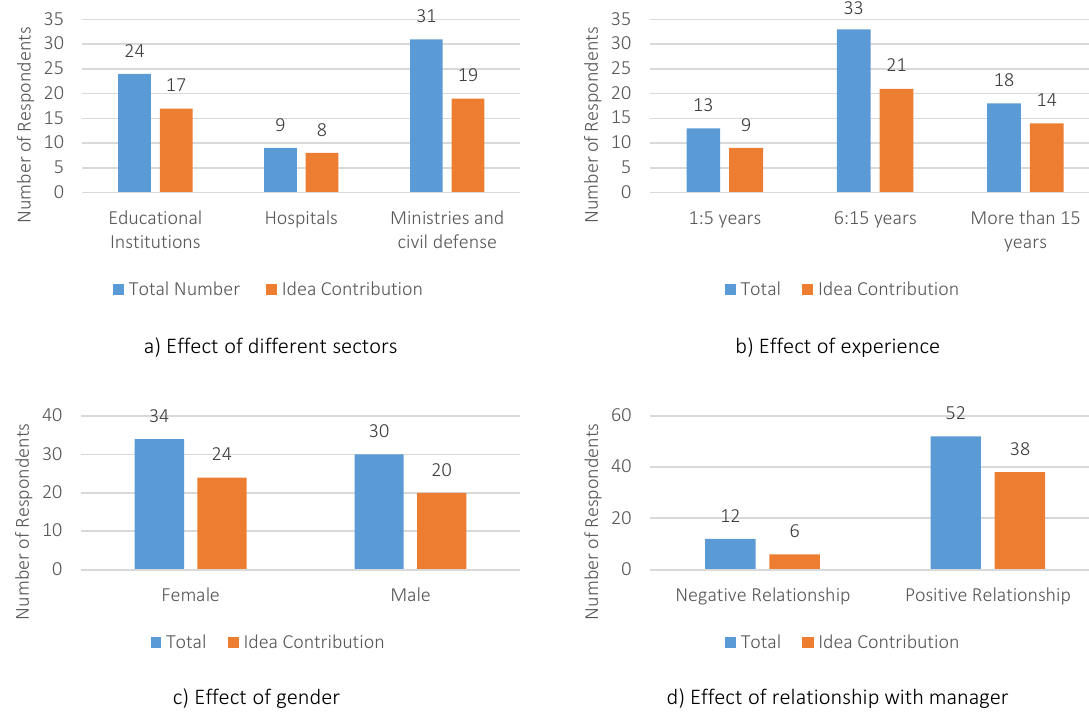
Figure 2. Effect of organization, experience, gender, and relationship with the manager on contributing ideas